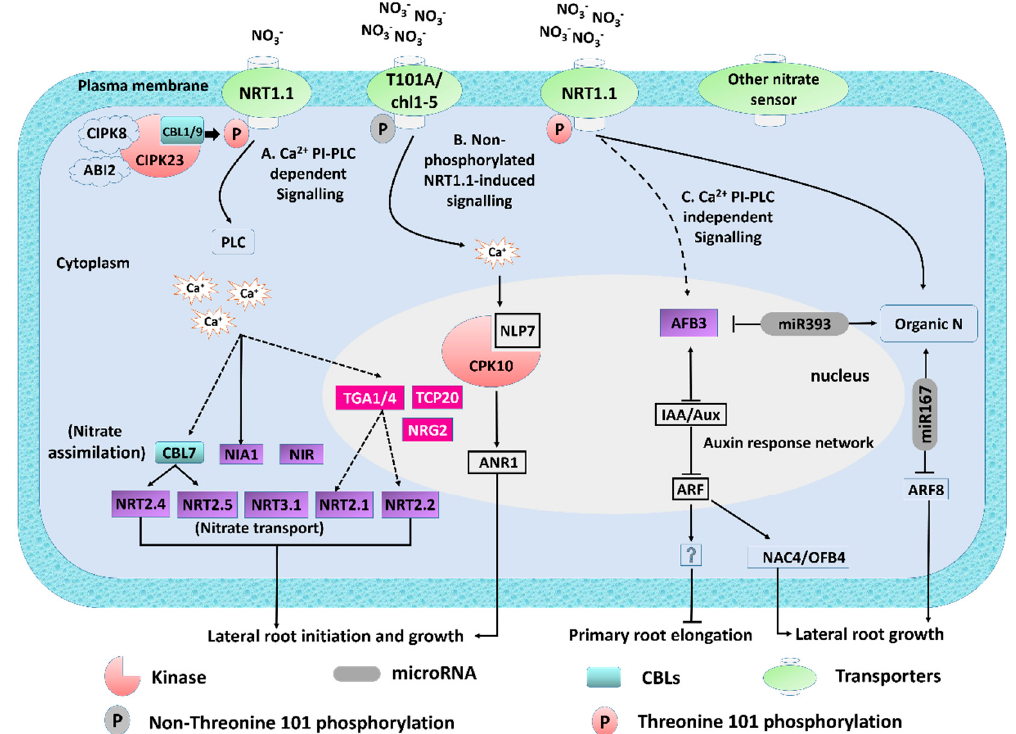
Figure 1. Summary of early responses in nitrate signaling and assimilation. NO 3 − signaling pathway switches its a ffi nity via phosphorylation (modified from Undurraga [41]). Nitrate-responsive genes are depicted in light green, transcription factors in purple, and microRNAs in grey. For clarity purposes, the cell nucleus is shown. Phosphatidylinositol-specific (PI-PLC) and Ca 2 + -dependent pathways. At Low NO 3 − condition, protein kinases CBL1 / 9–CIPK23 complex phosphorylates NRT1.1 and changes it into a high-a ffi nity transporter, which activates PLC and results in calcium influx (Ca 2 + acts as a second messenger). This cascade mediates changes in the expression of transcription factors ( TGA1 / 4 * ) and genes involved in nitrate transport ( NRT2.1 , NRT2.2 , and NRT3.1 ) and nitrate assimilation ( NIA1 and NiR ). Nonphosphorylated form of NRT1.1-induced signaling. Nitrate-induced Ca 2 + -ANR1